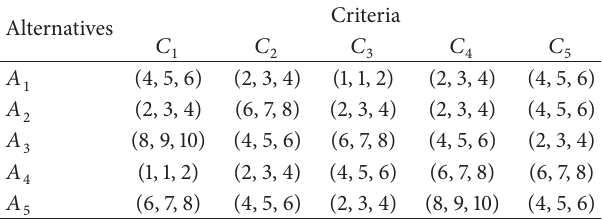
Table 4: Individual fuzzy decision matrix of DM 2 . Alternatives